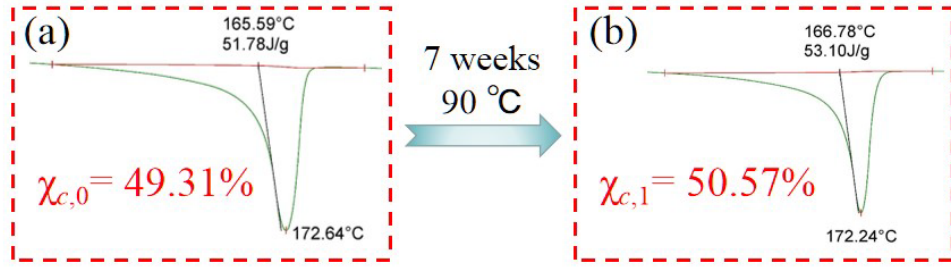
Figure 7. Melting curve of PVDF samples: ( a ) the original sample; ( b ) the sample exposed for 7 weeks at 90 °C.